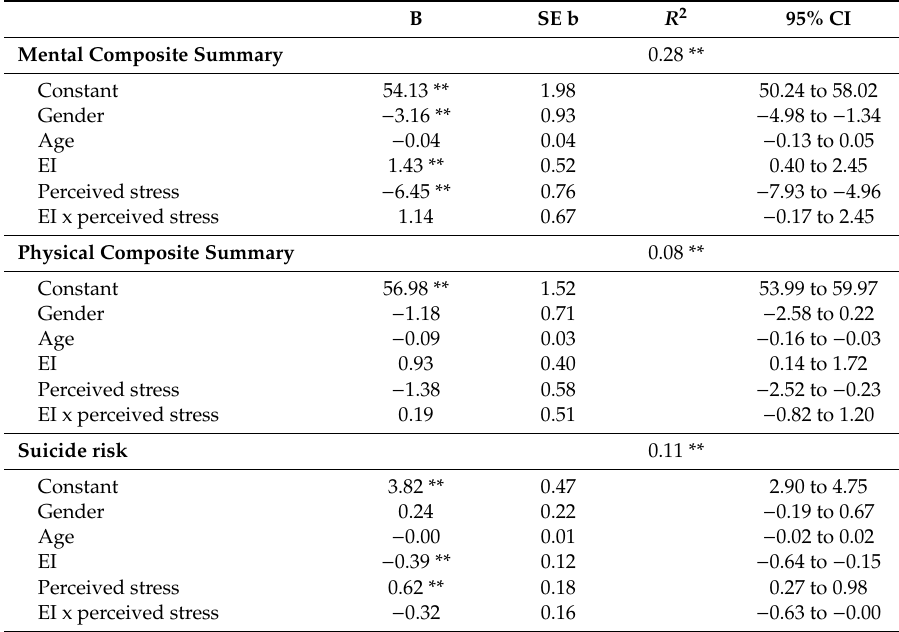
Table 2. Tested dependent variable models with mental health composite, physical health composite, and suicide risk as outcomes for short-term